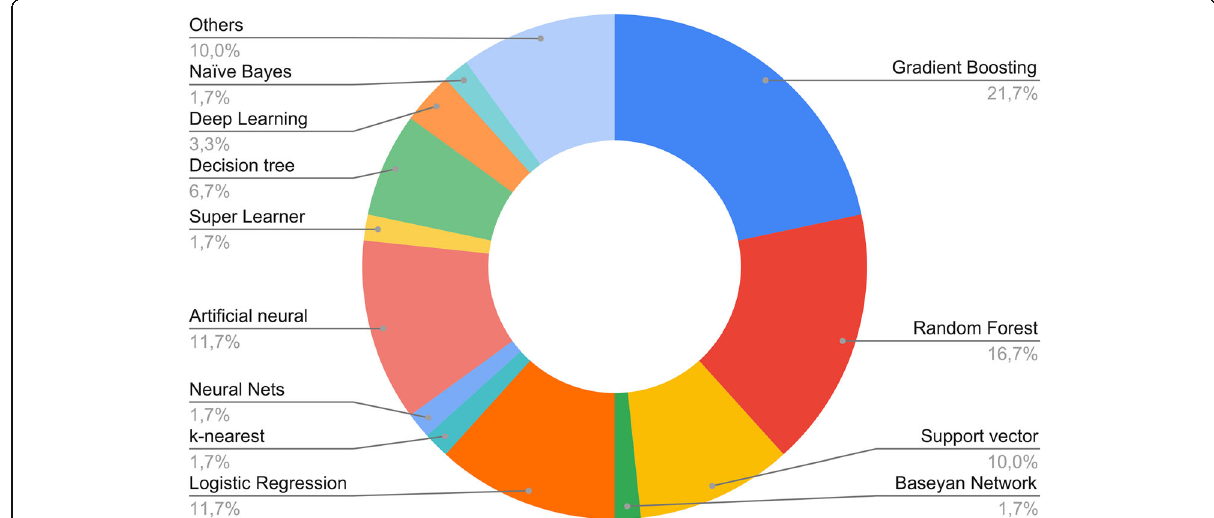
Fig. 5 Presentation of the main types of machine learning methods used in the analysis of our